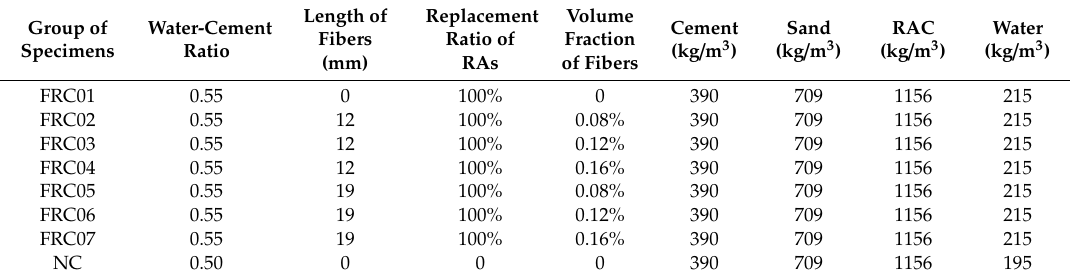
Table 5. Mixture proportions of concrete specimens.